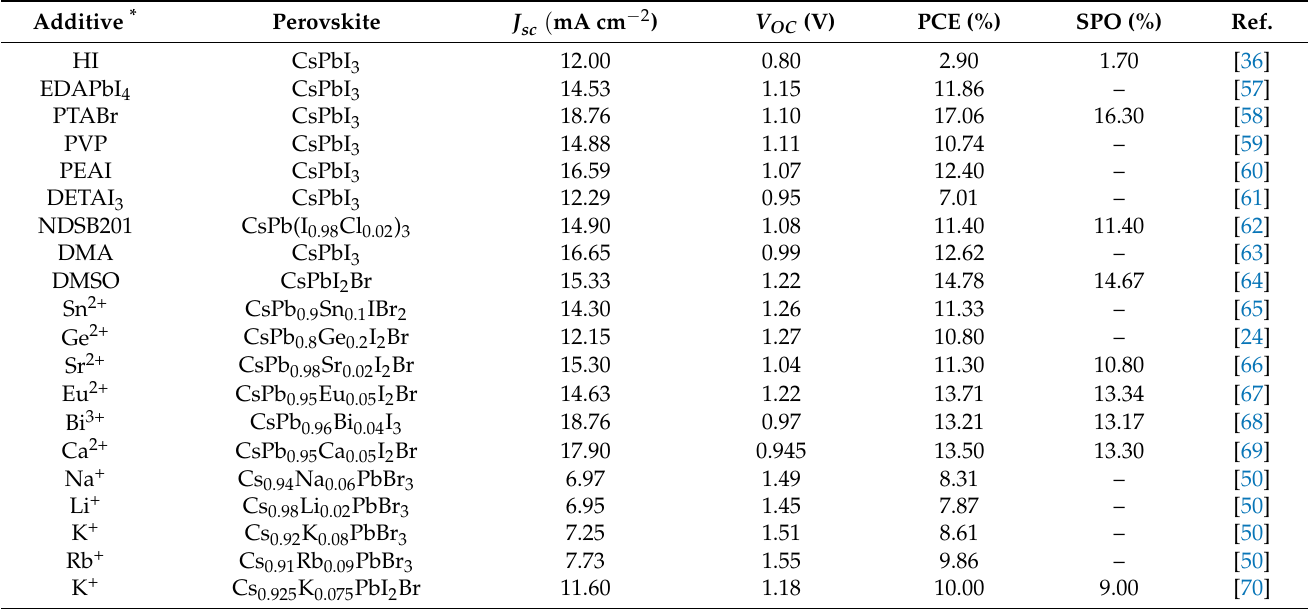
Lead-based inorganic perovskites SCs with different additives and their performance